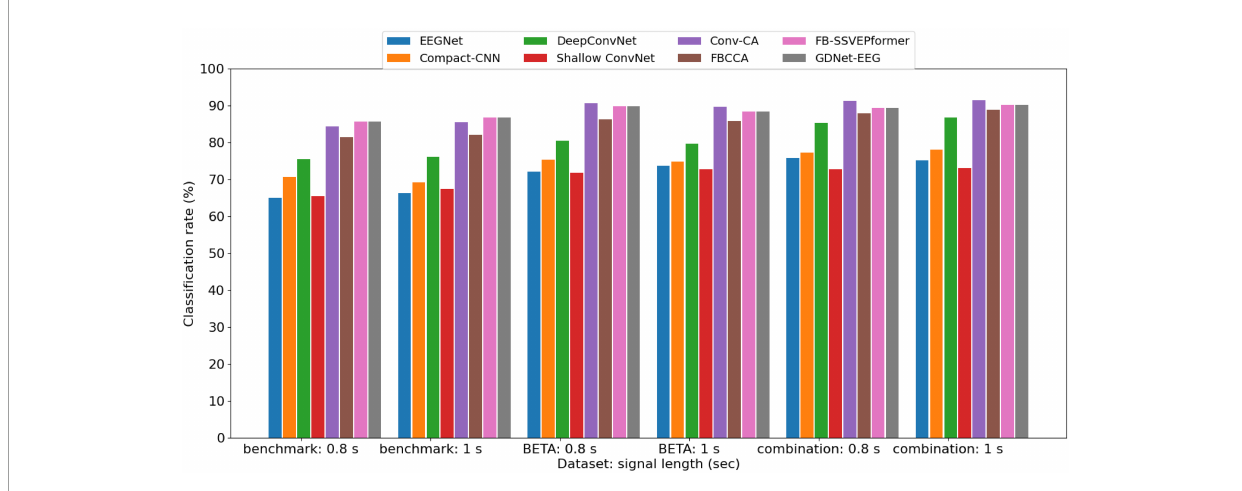
FIGURE5 The average classification accuracies obtained by GDNet-EEG and five other models over 10-fold cross-validation using a signal length of 0.8 and 1 s.